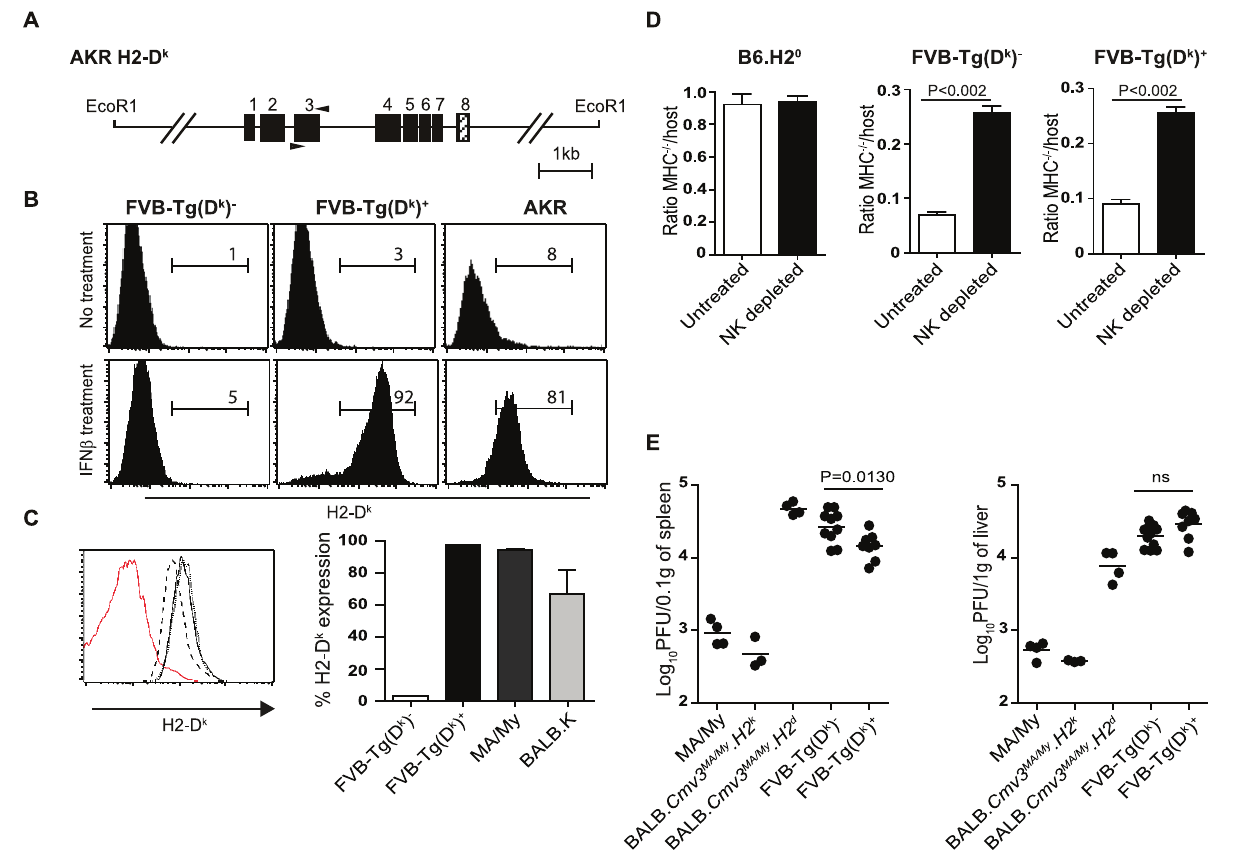
Figure 3. Functional characterization of H2-D k transgenic mice. (A) Schematic representation of the H2-D k gene within the 11.5 kb EcoRI genomic DNA fragment from AKR mice used to generate transgenic mice. (B) Expression of H2-D k on MEFs from FVB/N nontransgenic (FVB-Tg(D k ) 2 , transgenic FVB-Tg(D k ) + , and AKR ( H2 k ) mice. MEFs from FVB-Tg(D k ) + and wild-type littermates were prepared from PCR-typed embryos, untreated or incubated overnight with 100 U/ml IFN- b prior to analysis of H2 -D k expression by FACS. (C) H2 -D k staining on lymphocytes from FVB-Tg(D k ) 2 (red peak), BALB.K (dashed peak), MA/My (black peak), and FVB-Tg(D k ) + (dotted peak) mice. Bar graph shows quantification of the percentage of H2 -D k expression from 2–3 mice per group. (D) Splenocytes from B6. H2 0 mice or NKC/ H2 histocompatible mice were inoculated into either untreated or asialo-GM1–treated NK cell–depleted hosts. Ratio values indicate the relative survival in the test population (CFSE high ) compared to the histocompatible control population (CFSE low ) at 18 hours after injection. Three mice per group were analyzed. Statistical significance